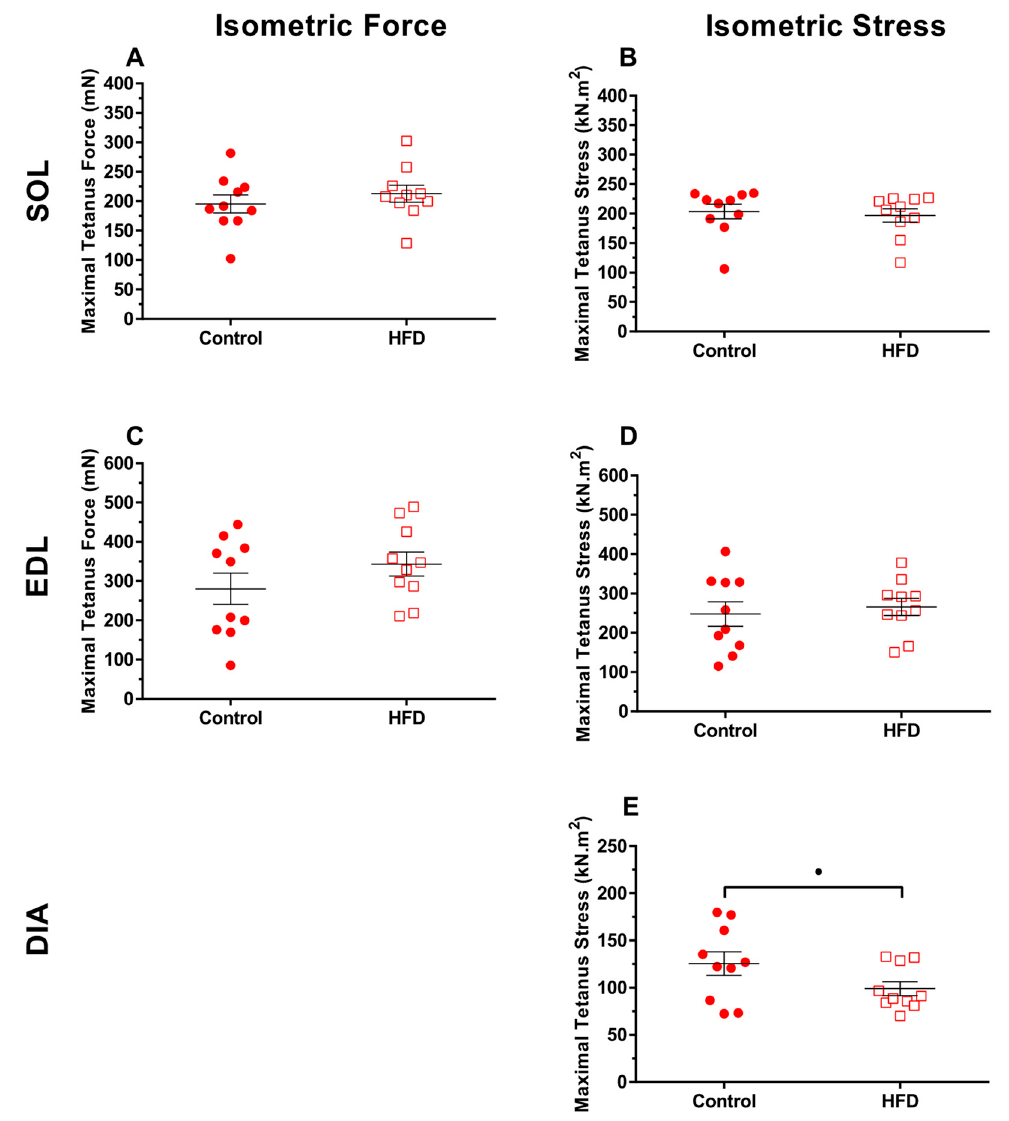
Figure 1. The effect of 9 weeks of a high-fat diet (HFD) on the absolute maximal isometric force ( A , C ) and maximal isometric stress ( B , D , E ) of isolated mouse soleus ( A , B ), EDL ( C , D ) and diaphragm ( E ) from 79-week-old mice. n = 10 per muscle per group. Absolute force is not presented for diaphragm due to slight differences in the segment of the diaphragm taken for each experiment. The • symbol indicates a statistical tendency ( P = 0.08) for isometric stress to be lower in the HFD group (ES = 0.78). Table 3. The effects of 9 weeks of a high-fat diet (HFD) on isometric activation (THPT) and relaxation (LSHR) of isolated mouse soleus, EDL and diaphragm from 79-week-old mice. THPT (ms) LSHR (ms) Effect Control HFD p -Value Size